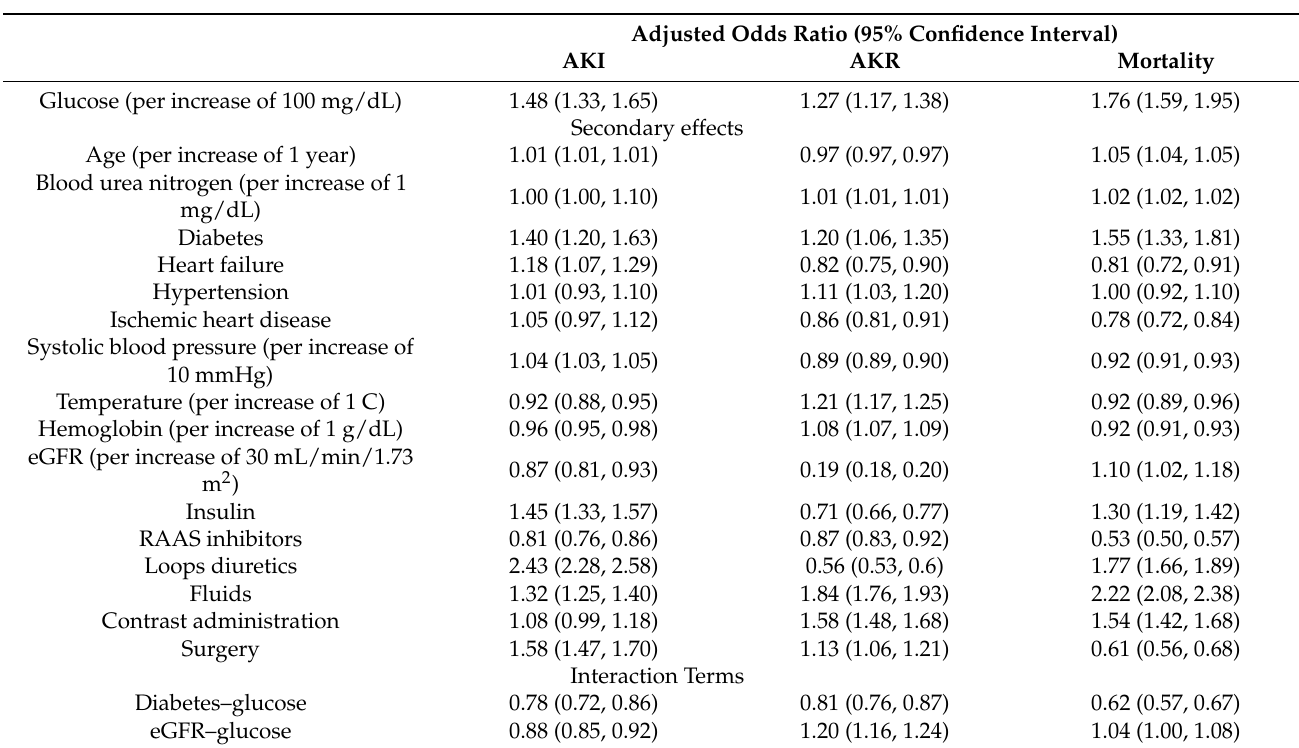
Table 2. Adjusted odds ratios of variables and interaction terms for the logistic regression models of acute kidney injury, acute kidney recovery and mortality.